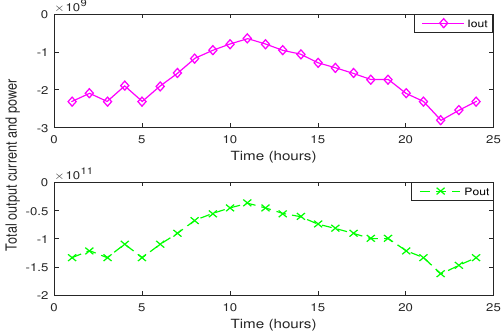
Figure 2. Total output power and current produced by Borowy’s